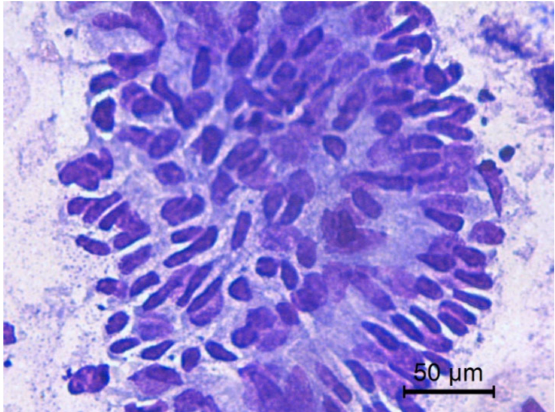
Figure 4. Jenny’s endometrial cytology collected by CB in estrus. Endometrial epithelial columnar cells. Modified Wright’s stain 400 × .